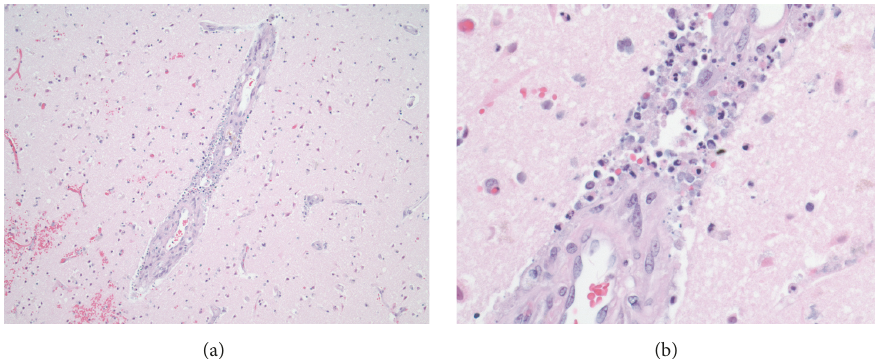
Figure 2: Histopathology of the cerebral cortex containing medium sized blood vessel. (a) H&E stain × 40 reveals acute inflammation concentrated in vessel wall. (b) H&E stain × 400 reveals acute necrotizing vasculitis; dense neutrophilic inflammatory exudate; and necrosis in vessel